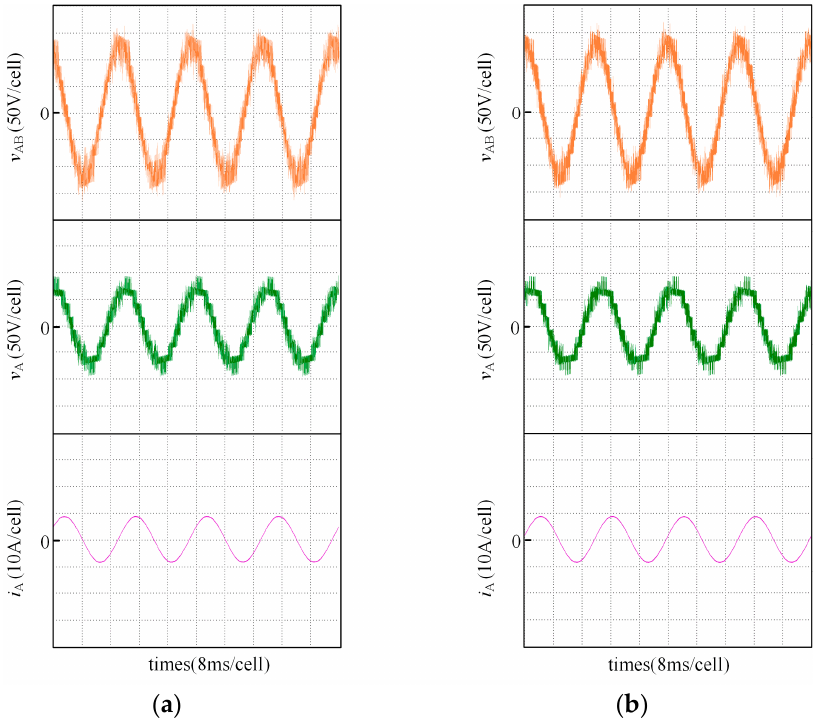
Figure 23. Experimental output waveforms of the converter at cos ϕ = 0.623 ( N = 4). ( a ) The proposed modulation method, ( b ) the conventional modulation